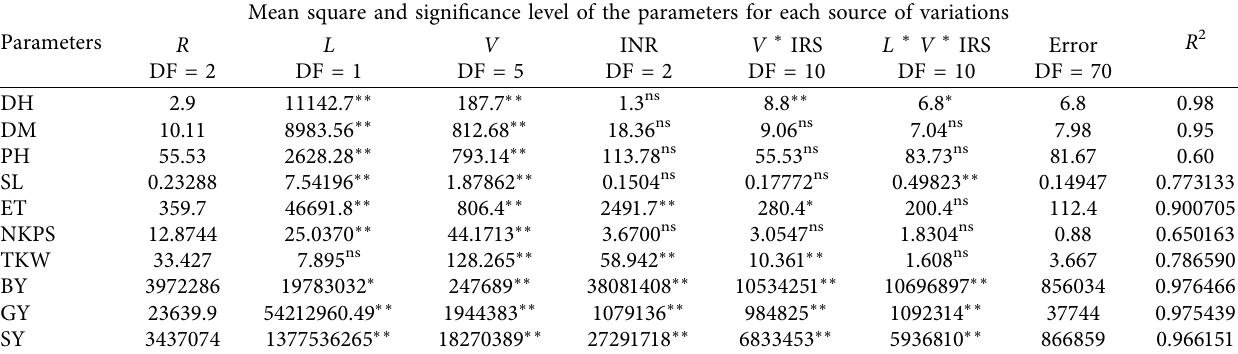
Table 1: Mean squares of ANOVA for the effect of variety, inter-row spacing. and location on DH, DM, PH, SL, ET, NPKS, TKW, BY, GY, and SY of malt barley at Debark, north Gondar, Ethiopia, in 2019. Mean square and significance level of the parameters for each source of variations Parameters